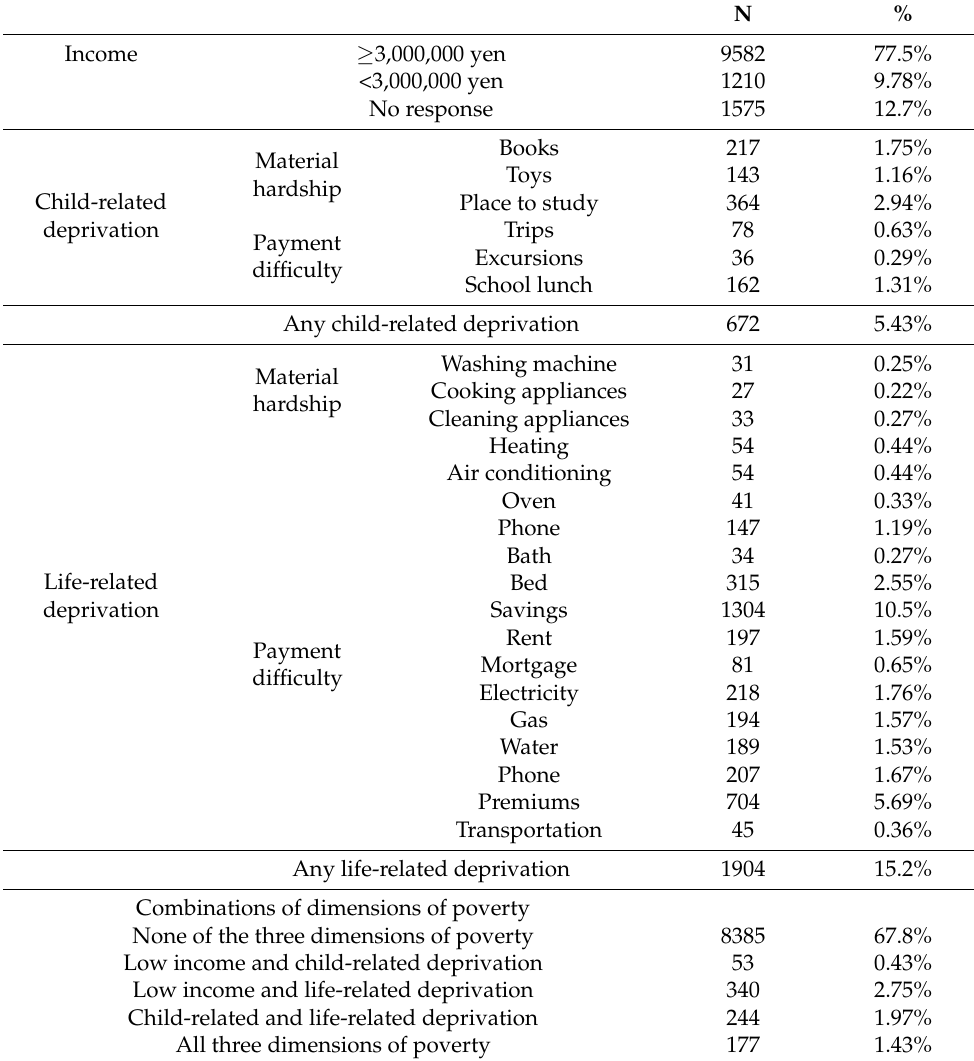
Table 2. Proportion with low income and child-related and life-related deprivation.